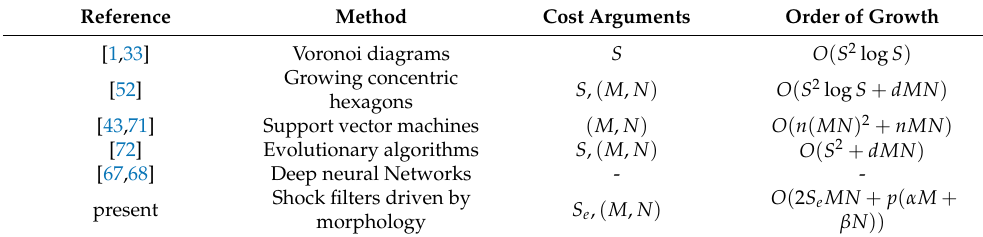
Table 3. Computational complexity analysis for microarray grid